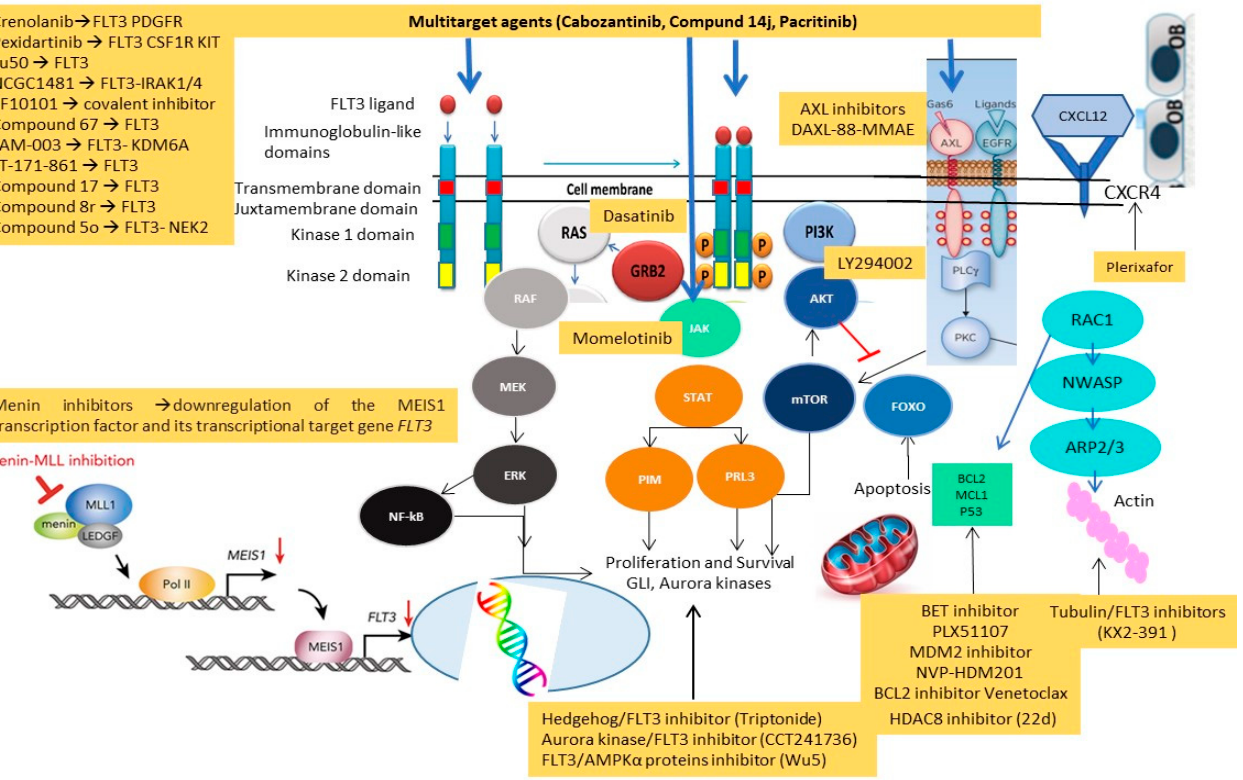
Figure 6. New target agents investigated in preclinical and phase I–II trials and their mechanisms of action. Table 5. List of ongoing clinical trials including chemotherapy or Hypomethylating agents andFLT3i. ClinicalTrial